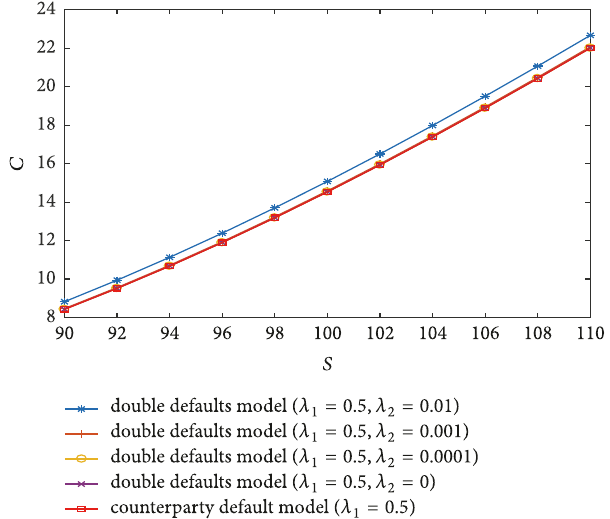
Figure 1: Call option prices versus stock prices for double defaults and counterparty default models with 𝛾 1 = 0.5, 𝛾 2 = 0, 𝛾 3 = −0.2, 𝑝 1 = 0.3, 𝑝 = 0.5, 𝑝 = 0.2, 𝑇 = 1, 𝑟 = 0.05, 𝜎 2 3